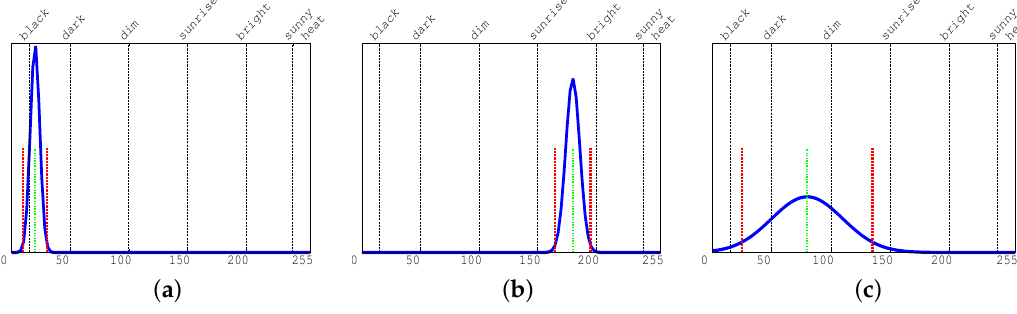
Figure 4. Gray histograms for: ( a ) a uniform dark cell, ( b ) a uniform bright cell, ( c ) a non-uniform dark cell. Vertical lines represent average (green) and variance (red) on all bins.